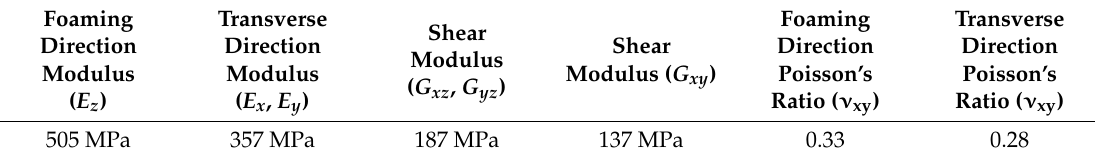
Table 1. Elastic moduli and Poisson’s ratio used in constitutive model for the analogue bone.